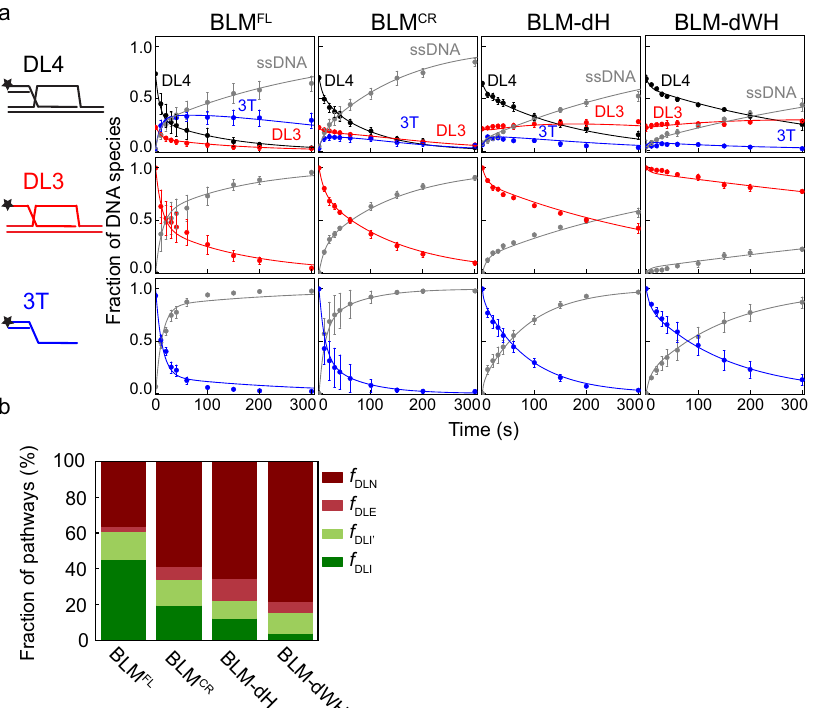
Fig. 4 BLM alone does not effectively disrupt D-loop invasions. a Kinetic pro fi les of DL4, DL3, and 3T unwinding by BLM FL , BLM CR , BLM-dH, and BLM- dWH. Fractions of DNA species were determined by pixel densitometry from I-trap D-loop unwinding experiments (a typical result is shown for BLM FL in Fig. 2c). Color coding of fractions of DNA species is as in Fig. 3 (DL4 (4-stranded D-loop-like structure): black, DL3 (3-stranded D-loop-like structure): red, 3T (3 ′ -tailed dsDNA): blue, ssDNA: gray). Solid lines show global best fi ts of the model shown in Fig. 3 to all unwinding data (DL4, DL3, and 3T) of each enzyme variant. DNA substrates and DNA species observed during the reaction are described in Fig. 2b and Methods. For all BLM constructs, the disappearance of DL4 during the unwinding time courses was accompanied by a transient accumulation of 3T, eventually converted to ssDNA. Similar kinetic pro fi les were obtained for RecQ constructs 19 . Means ± SEM ( n = 3) are shown on all panels for the detected fractions of DNA species at each time point determined from independent experiments with individual protein constructs. b Distributions of enzyme – DL (DL4 or DL3) con fi gurations obtained from global fi ts shown in panel a (determined parameters are listed in Supplementary Table 1). Deletion of the NC region (BLM CR construct) increased the fraction of both the DLE and DLN pathways (cf. Fig. 3), however, the NC regions are dispensable for strong binding to DL4, DL3, or 3T (Supplementary Fig. 3b and c). Further deletion of the HRDC domain (BLM-dH) slightly increased the fraction of the DLE and DLN pathways, meanwhile, it lowered the fraction of the DLI pathway (compared with BLM CR ). These results suggest that the HRDC domain plays a minor role in promoting speci fi c BLM – D-loop interactions, in line with DL4, and DL3 binding measurements (Supplementary Fig. 3d). Deletion of the BLM WHD and HRDC domains (BLM-dWH) further increased the fraction of the DLN pathway, whereas it decreased the DLI fraction and decreased the unwinding ef fi ciency of the 3T substrate (panel a), indicating a moderately lowered unwinding processivity compared with that of other constructs. Source data are provided as a Source Data fi